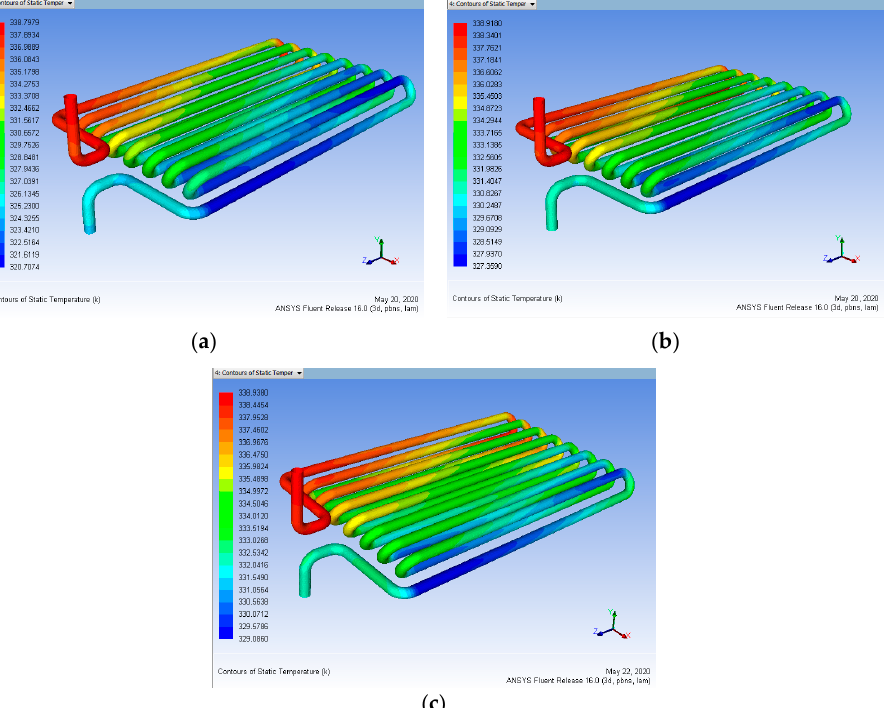
Figure 17. Heat input 343 K vs. Coating Thickness 50 µm for mass flow rate ( a ) 0.15, ( b ) 0.30, ( c ) 0.45 L/min (After Coating).